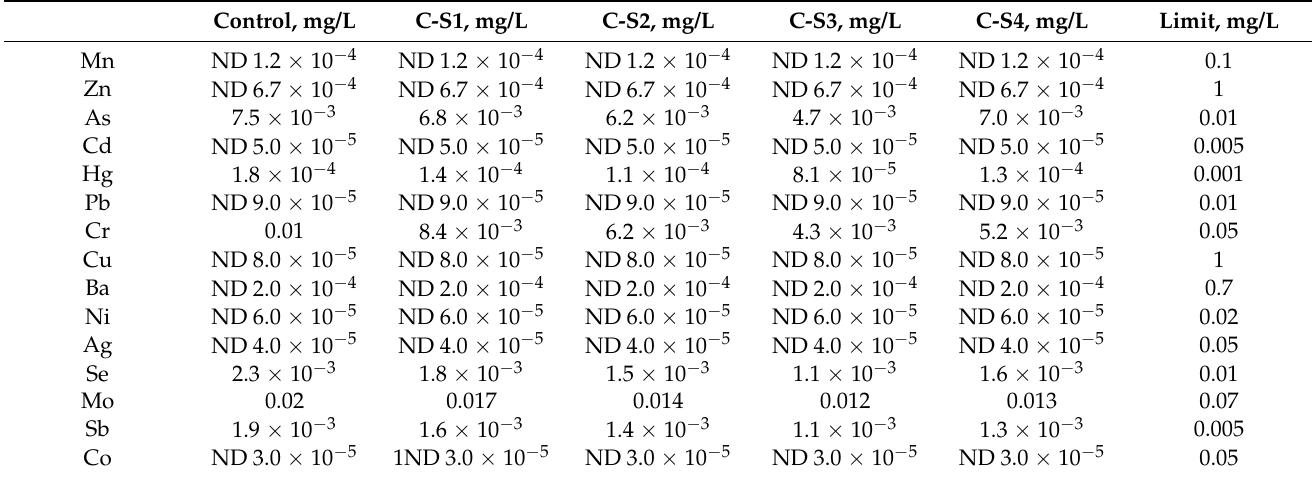
Table 5. Leaching results of